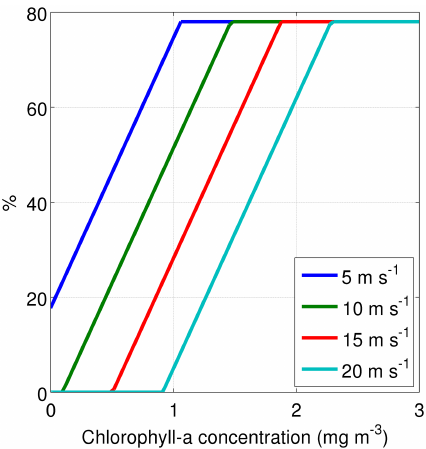
Figure 2. Dependence of organic mass fraction of sea spray emis- sions (Rinaldi et al., 2013) on the oceanic chlorophyll a concentra- tion and 10m wind